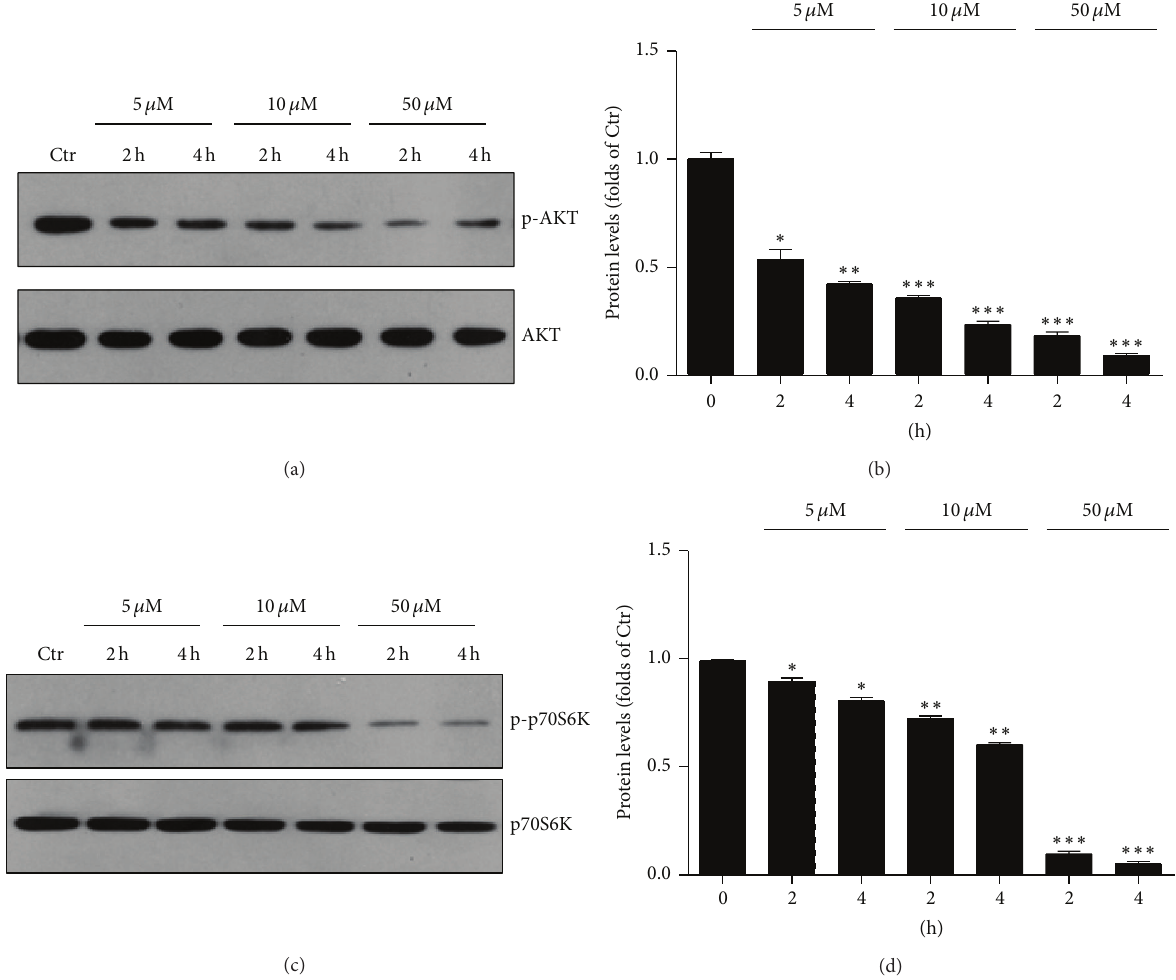
Figure 4: 4-HNE inhibits AKT pathways in MG63 cells. (a)-(b) Western blots (a) and histograms (b) showing the decreasing of protein levels of pAKT by 4-HNE treatment (5 to 50 𝜇 M, and 2h to 4h) in MG63 cells. Results are averages of three independent experiments. (c)-(d) Western blots (a) and histograms (b) showing the decreasing of protein levels of pp70S6K by 4-HNE treatment (5 to 50 𝜇 M, and 2h to 4h) in MG63 cells. Results are averages of three independent